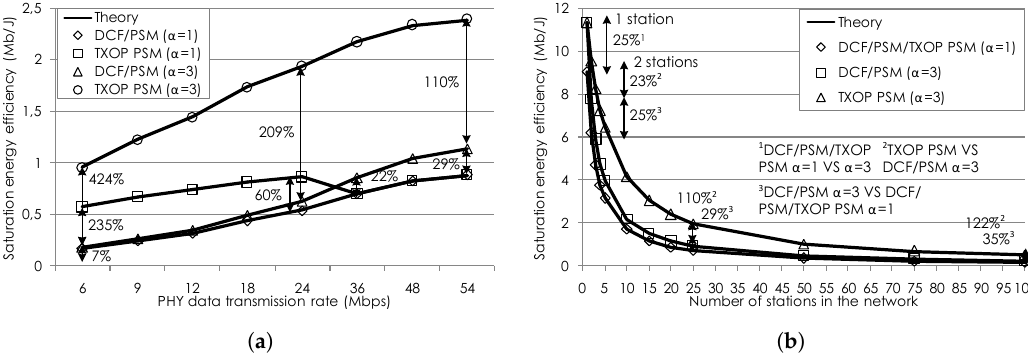
Figure 4. Saturation energy efficiency of the evaluated mechanisms with α = 1 and α = 3 rounds of data transmissions as a function of the PHY data transmission rate and the number of STAs. ( a ) PHY data transmission rate. ( b ) Number of